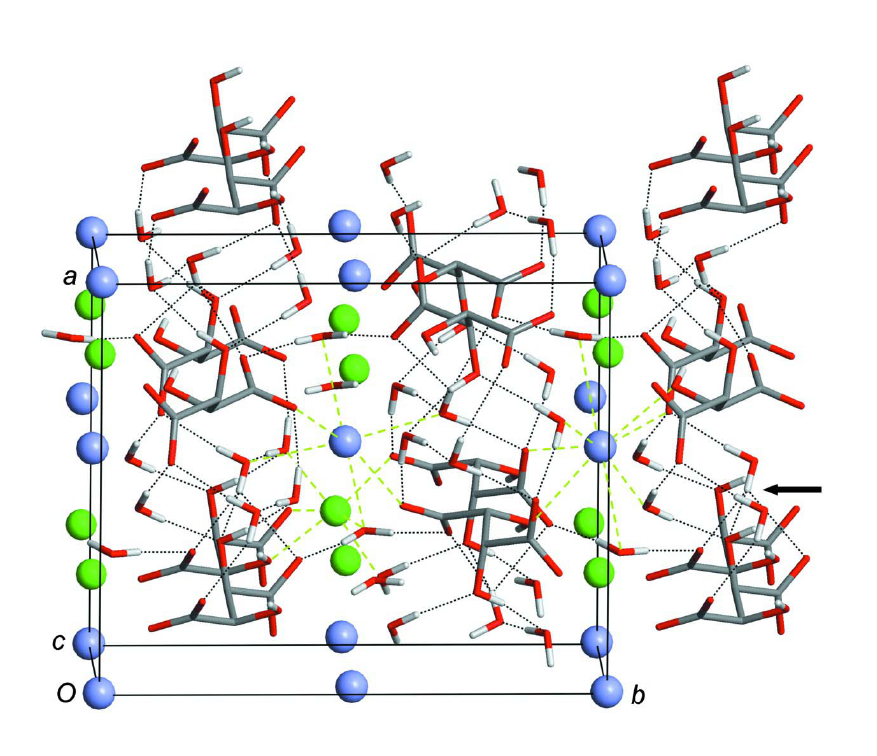
Figure 2 Crystal packing arrangement viewed approximately along the c axis. H atoms bonded to C have been left out for clarity. Na + is yellow, K + is light blue with K1 at the centre of the unit cell and K2 at the cell edge. Hydrogen bonds are shown as black dotted lines while ligand coordination is indicated in orange for three selected metal ions. The arrow points to H31W, which is involved in a four-center hydrogen